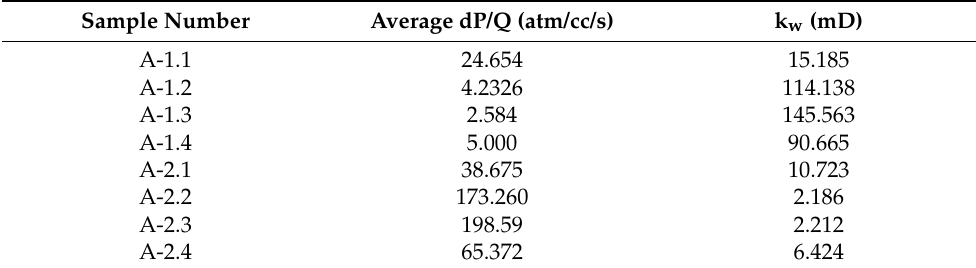
Table 6. Water permeability values of all eight core plug samples.